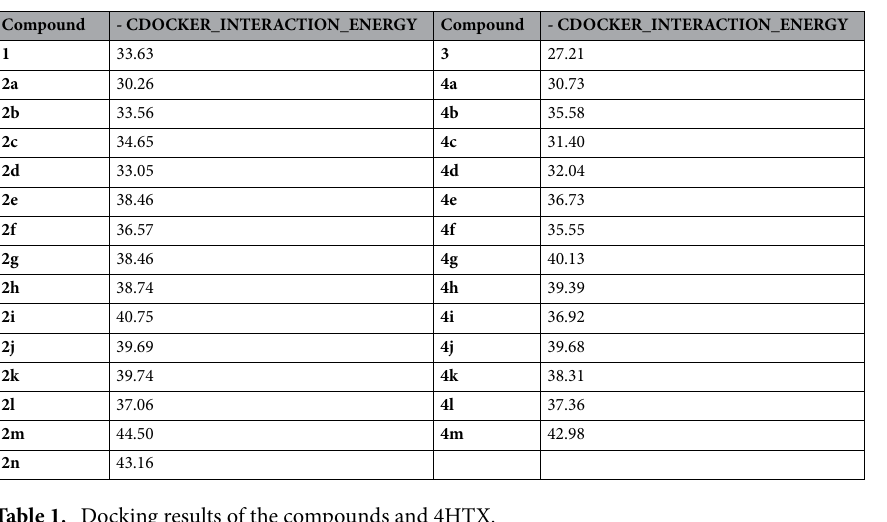
Table 1. Docking results of the compounds and